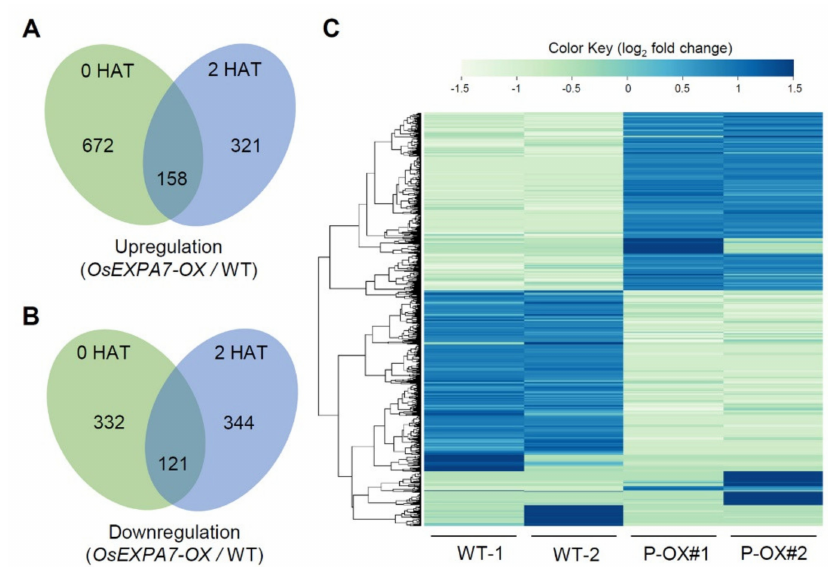
Figure 8. Venn diagram and heatmap of di ff erentially expressed genes (DEGs) under salt stress. ( A , B ) Analysis of DEGs in the roots of two-week-old WT and PGD: OsEXPA7 plants sampled 2 HAT. The Venn diagram shows the overlapping annotations between WT and OX lines. ( C ) Heatmap